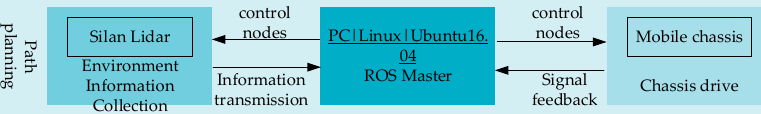
Figure 2. Mobile chassis control system diagram.